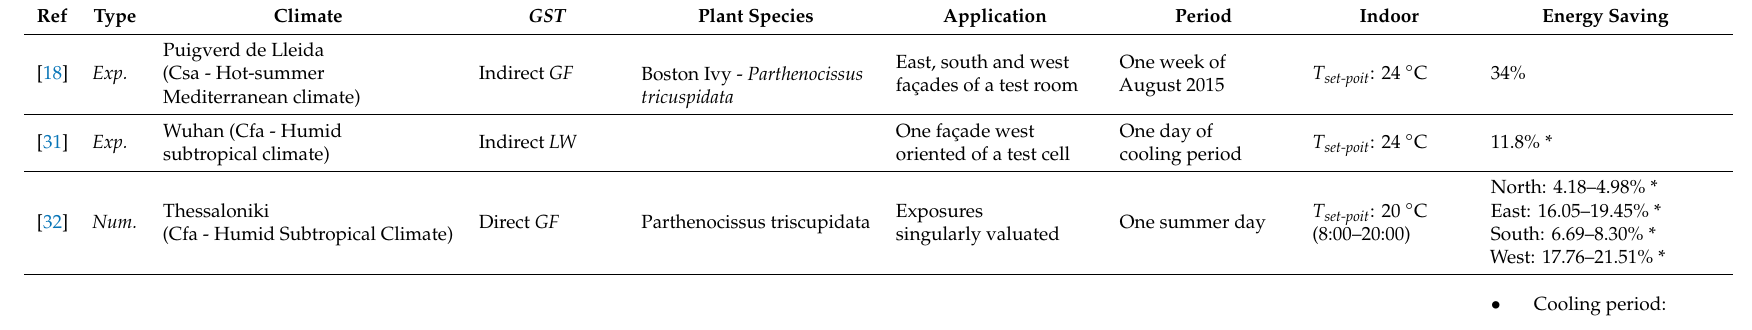
Table 4. Results about energy